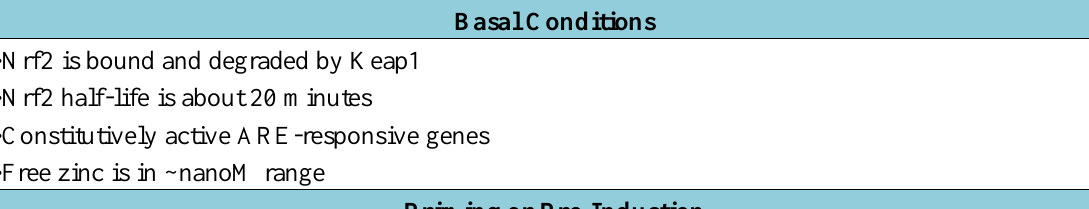
Table 1. Overview of Nrf2 and changing cellular redox